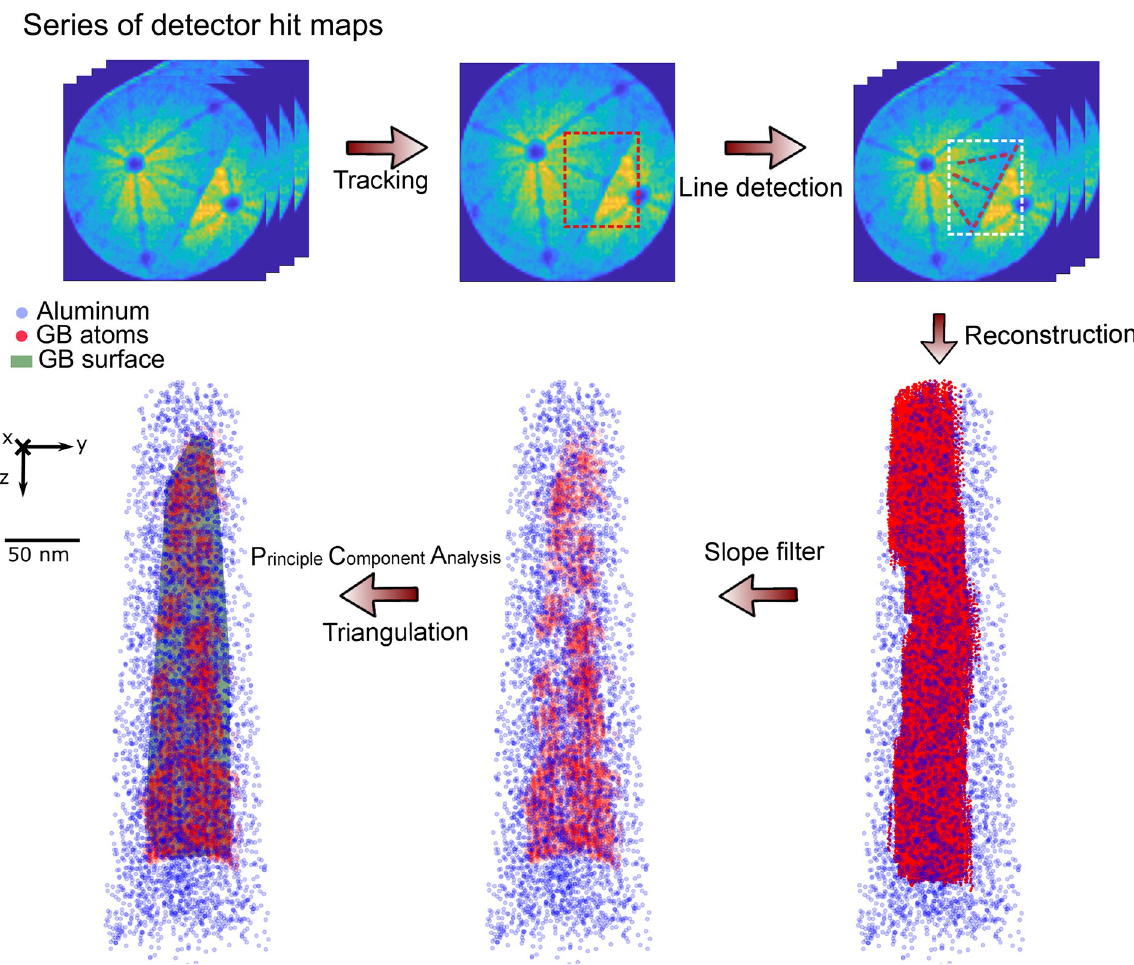
Fig 5. A flowchart of the BooT-PCA on an aluminum bi-crystal dataset: Firstly, image processing is performed on a series of detector hit maps, secondly tracking and line detection are performed. Next the collected data is reconstructed into 3D Cartesian coordinates, thirdly, a slope filter, PCA and triangulation (consists of mesh vertices) are applied sequentially to filter out zone lines atoms and fully reconstruct the GB surface.